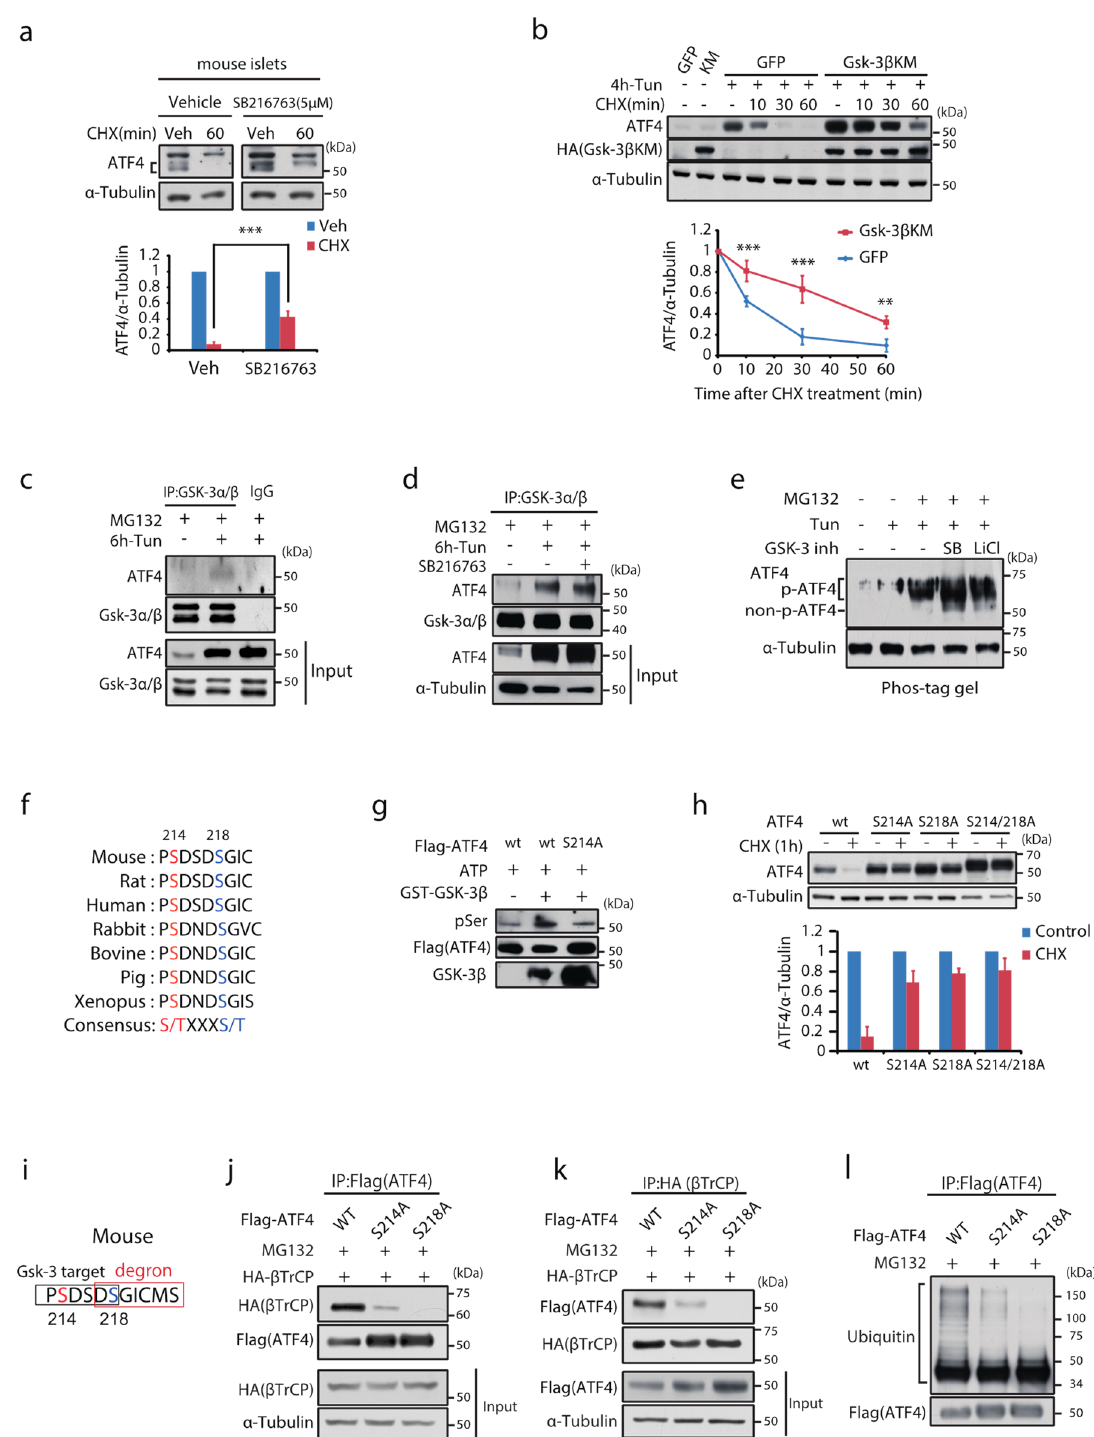
Figure 2. Gsk-3 promotes ATF4 protein degradation through phosphorylation of Ser 214. ( a ) CHX- chase assay for ATF4 protein in isolated islets incubated with tunicamycin (5 μ g/mL) in the presence or absence of SB216763 (5 μ M) for 4 h. Relative expression of ATF4 to the basal is shown as mean ± SD (n = 3). *** p < 0.001 by one-way ANOVA followed by Bonferroni’s post hoc test. ( b ) CHX-chase analysis for ATF4 induced by a 4 h incubation with tunicamycin in MIN6 stably expressing GFP or HA-Gsk-3 β KM. Relative change of ATF4 to the basal of cells with GFP expression are expressed as mean ± SD (n = 3). ** p < 0.01, *** p < 0.001 by two-way ANOVA followed by Bonferroni’s post hoc test. MIN6 were incubated with tunicamycin (5 μ g/mL) for 4 h, followed by a 2 h treatment with MG132 (25 μ M). ( c ) Immunoprecipitation was performed using the anti-Gsk-3 α / β antibody or non- specific IgG and the immunoprecipitants and the input were analysed by Western blotting using